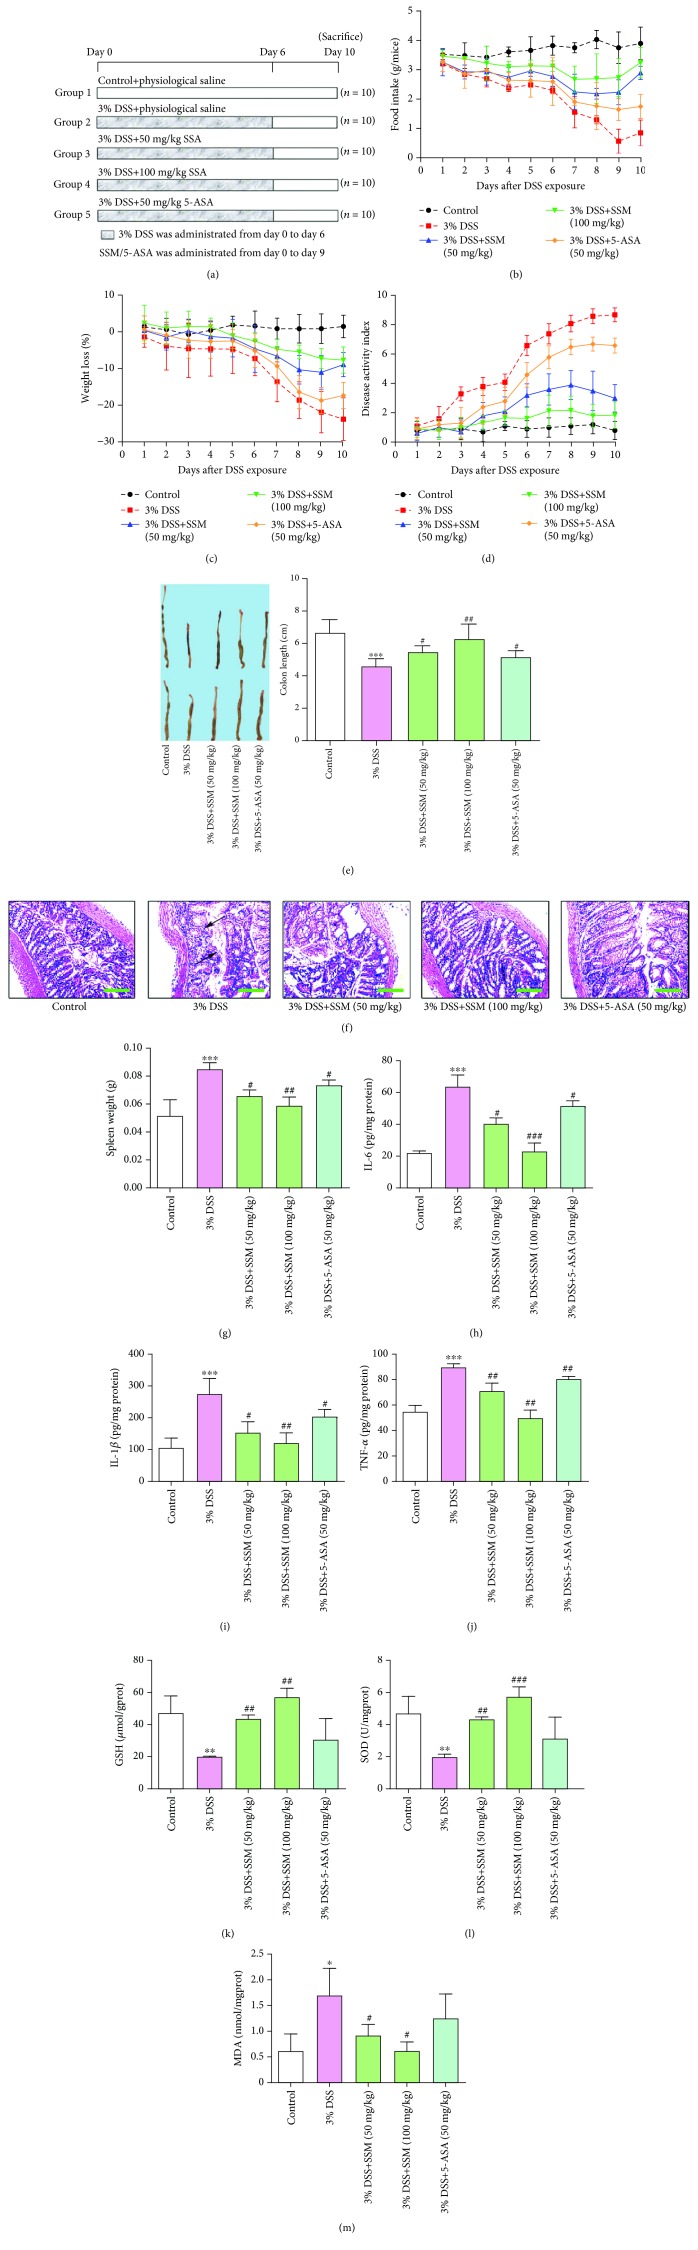
SSM alleviated DSS-induced acute colitis in mice by reversing proinflammatory cytokine release and antioxidation inhibition. (a) The schematic of the experimental design used in the study. (b) Changes in dietary intake. (c) Changes in body weight. (d) Changes in disease activity index (DAI). (e) Colon length in different treatment groups. (f) The colons collected on day 10 were sectioned and then stained with hematoxylin and eosin (H&E). Arrows indicate the epithelial erosion and crypt distortion and abscess. Images are displayed at 40x magnification using a bright field microscope. (g) Changes in spleen weight. (h–j) The amount of IL-6, IL-1β, and TNF-α in colon tissues of mice was determined using commercial ELISA kits. (k–m) The activity of SOD and the amount of GSH and MDA were determined in colon tissues of mice using commercial ELISA kits. Data were expressed as the mean ± SD (n = 10). ∗p < 0.05, ∗∗p < 0.01, and ∗∗∗p < 0.001 versus the control. #p < 0.05, ##p < 0.01, and ###p < 0.001 versus the 3% DSS treatment group.